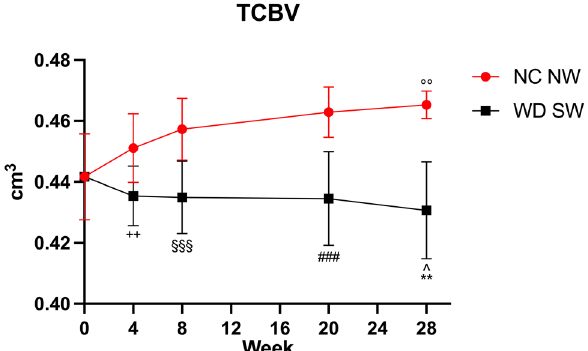
Figure 2. Total cerebral brain volume for the NC NW (red) and WD SW (black) mice during the 24 weeks investigated. T0: 0 weeks, T1: 4 weeks, T2: 8 weeks, T3: 20 weeks, T4: 28 weeks. The results are expressed as mean ± S.D. ^: p < 0.05 vs WD SW T0, **: p < 0.01 vs NC NW T4, °°: p < 0.01 vs NC NW T0, + + : p < 0.01 vs NC NW T1, §§§: p < 0.001 vs NC NW T2, ###: p < 0.001 vs NC NW T3. NC NW: Normal Chow Normal Water, WD SW: Western Diet Sugar